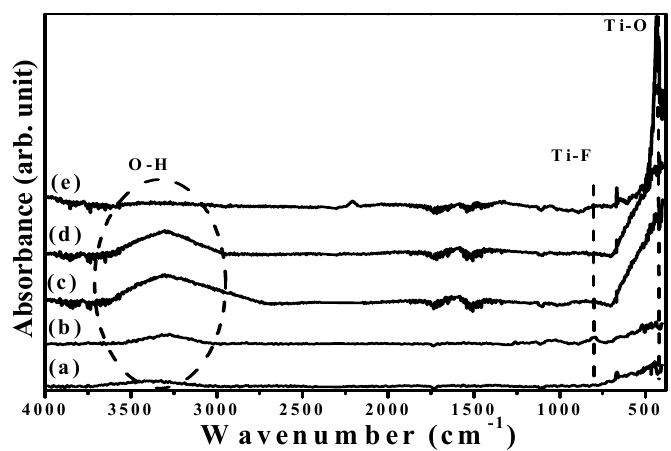
Figure 7. FTIR spectra of the ( a ) untreated; and ( b ) SFE-treated base layers and the a-TiO x films deposited onto the ( c ) untreated; and ( d ) SFE-treated base layers; as well as ( e ) the annealed TiO x film.